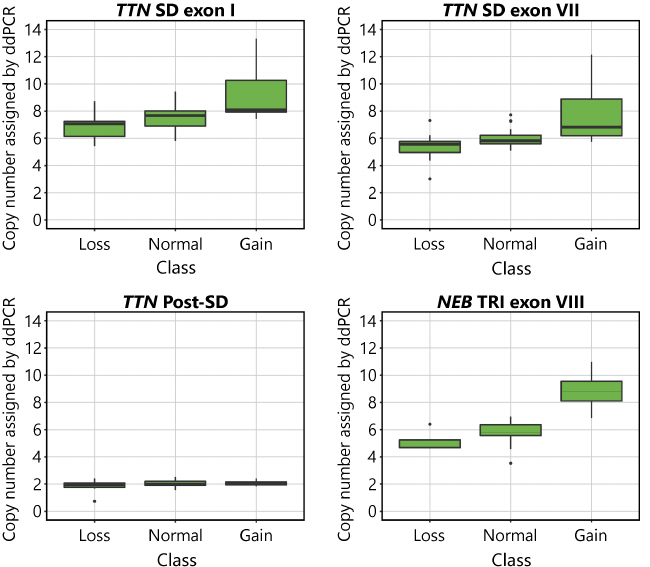
Figure 2. Boxplots visualising the CN of the TTN SD exon I, TTN SD exon VII, TTN Post-SD and NEB TRI exon VIII assays in relation to the CN assigned by aCGH to the TTN SD in the TTN targeting assays, and the NEB TRI in the NEB targeting assay. The normal CNs for the assays are 8 for TTN SD exon I, 6 for TTN SD exon VII, 2 for TTN Post-SD, and 6 for NEB TRI exon VIII. In the TTN targeting assays, 9 samples were categorised in the gain group, 35 in the normal group, and 11 in the loss group, according to their TTN SD CN estimated by the NMD-CGH-array. In the NEB TRI exon VIII assays, 4 samples were categorised in the gain group, 47 in the normal group, and 4 in the loss group, according to their NEB TRI CN as estimated by the NMD-CGH-array. The error bars represent the 95% confidence